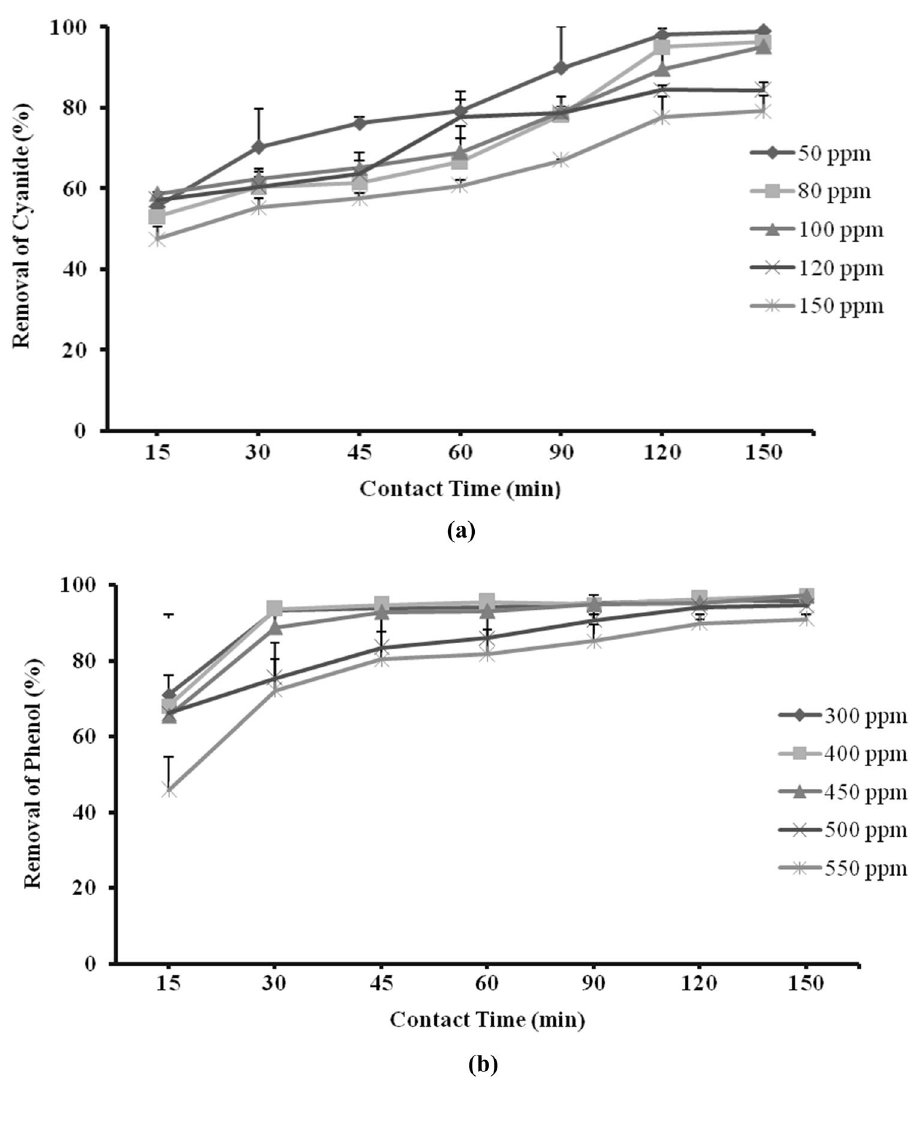
Fig. 8 a Variation of removal of cyanide with contact time taking initial concentration of cyanide as parameter. b Variation of removal of phenol with contact time taking initial concentration of phenol as parameter